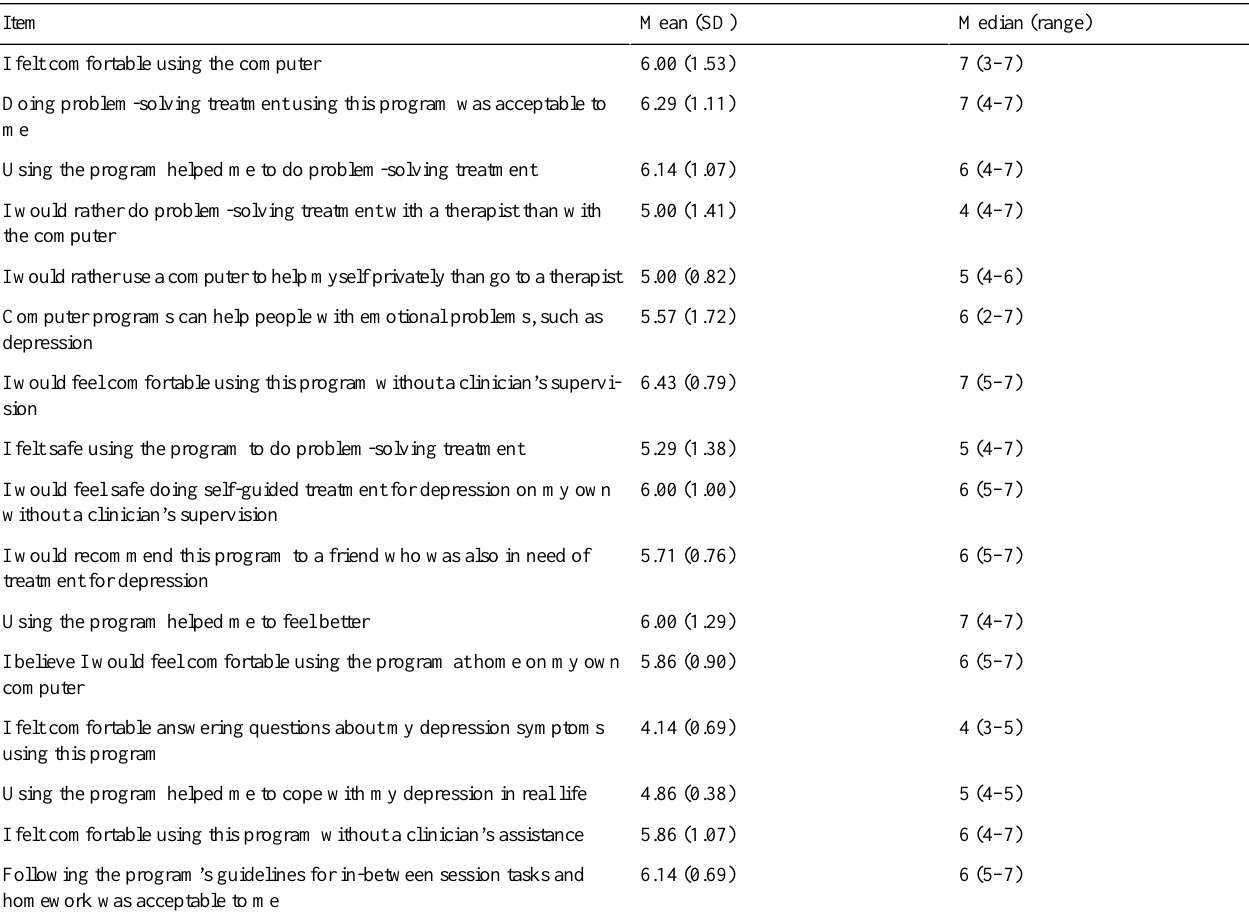
Table 3. Acceptability of Self-guided Treatment Questionnaire scores (n = 7).